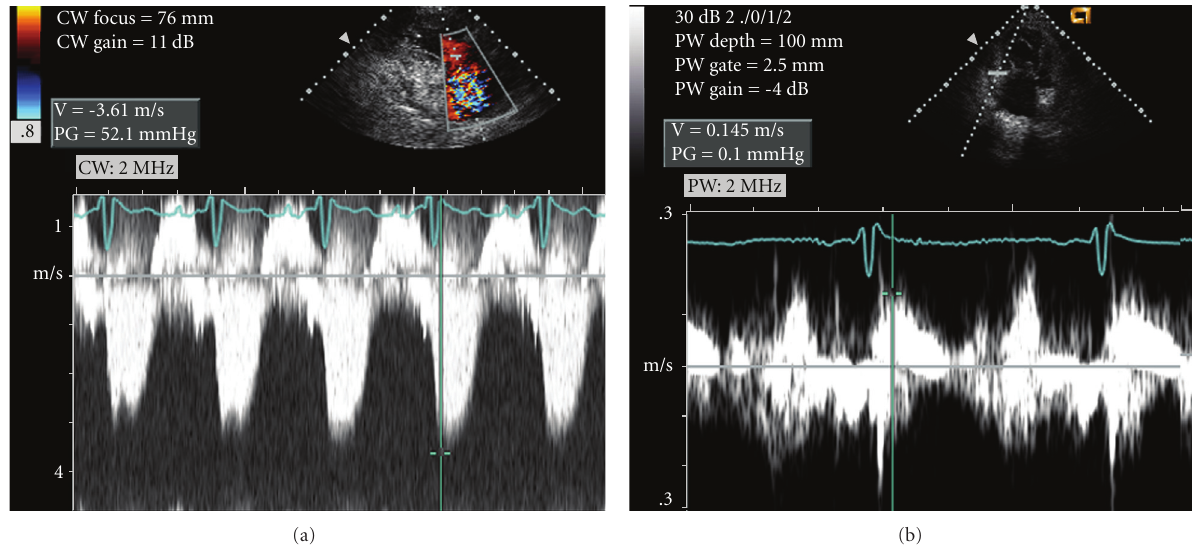
Figure 2: (a) Continuous wave Doppler profile of tricuspid regurgitation in the parasternal long-axis view. The tricuspid valve regurgitant velocity is 3.61 m/s. Using the modified Bernoulli equation ( Δ P = 4 V 2 ) and assuming a right atrial pressure of 15 mmHg, the estimated pulmonary artery systolic pressure is 67 mmHg. (b) Tissue Doppler profile of the tricuspid valve annulus demonstrates a systolic velocity of 14.5cm/sec consistent with preserved right ventricular function [1,